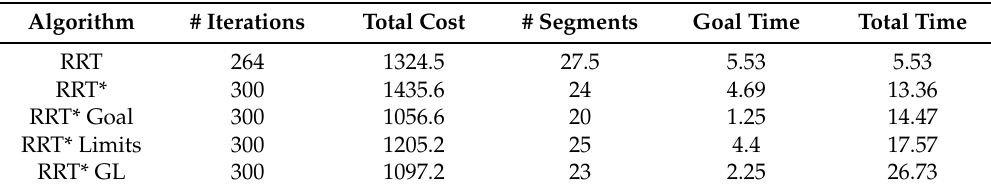
Table 10. Results. Three obstacles, 300 iterations.